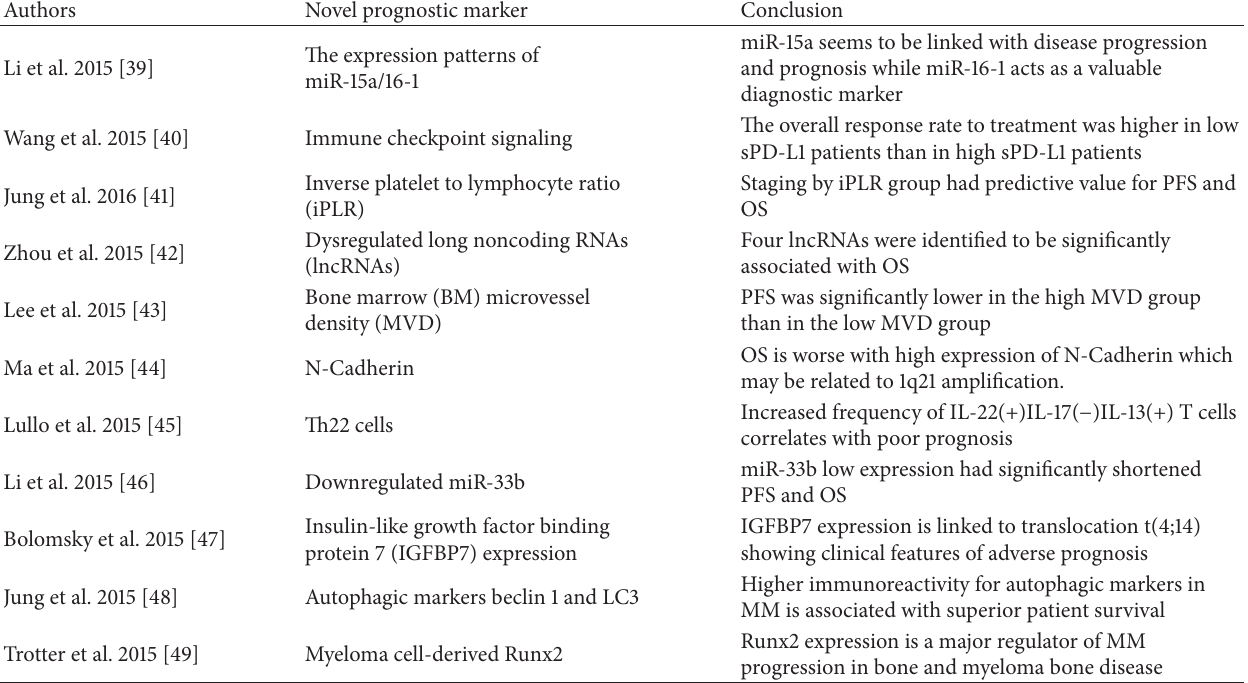
Table 2: Summary of some of the novel prognostic markers that were published